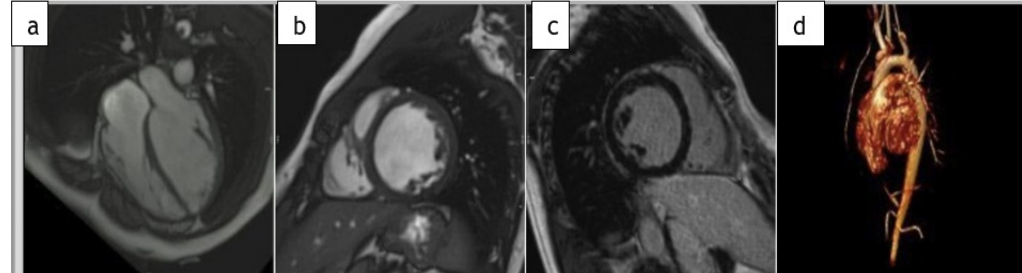
Figure 2. 1,5 Tesla cardiac magnetic resonance (CMR) showing a moderately dilated, hypokinetic left ventricle at 4 chamber ( a ) and midventricular short-axis view ( b ); ( c ) shows post contrast short axis view excluding late gadolinium enhancement (LGE). ( d )Three-dimensional reconstruction of aortic arch where no signs of recoarctation were detected.